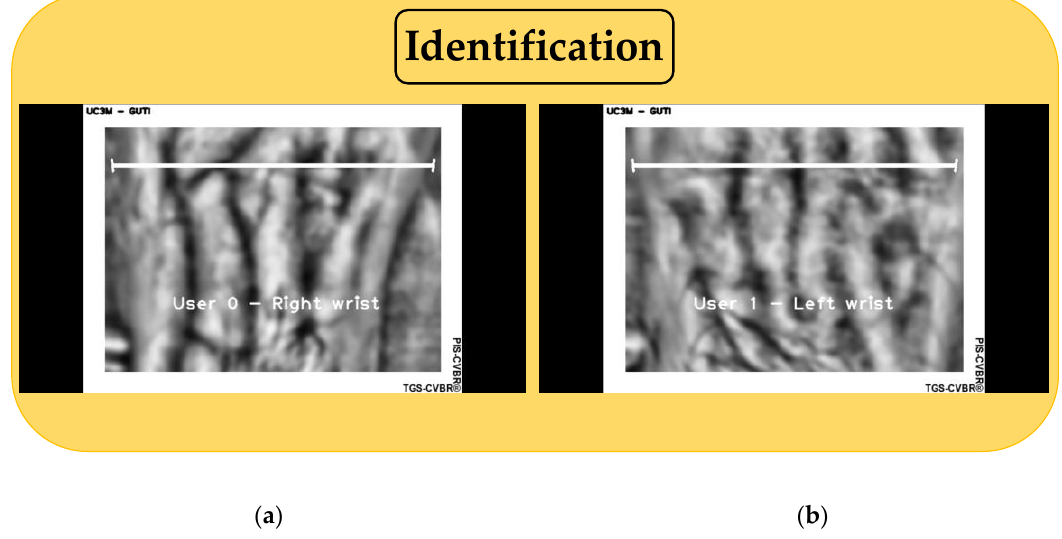
Figure 8. Final system software: User 0 and User 1 real-time identification using TGS-CVBR ® and PIS-CVBR ® (SIFT algorithm). ( a ) User 0 capture. ( b ) User 1 capture.